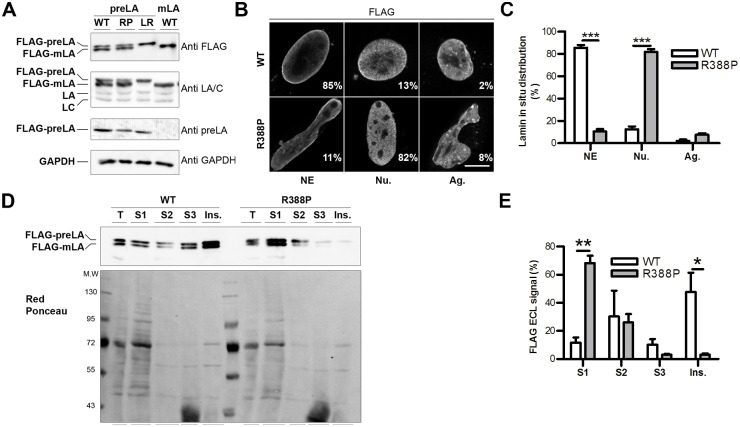
p.R388P mutation alters solubility and nuclear envelope targeting of lamin A.A) Whole cell extracts of C2C12 cells overexpressing wild-type (WT), R388P (RP), L647R (LR) FLAG-LA or WT FLAG-mature LA (mLA) were analysed by western blot using anti-FLAG, anti-LA/C (which recognise ectopic and endogenous A-type lamins), anti-prelamin A (preLA) and anti-GAPDH antibodies. B) C2C12 cells overexpressing WT or R388P FLAG-LA were fixed, labelled with anti-FLAG antibodies, and immunofluorescence observed at the confocal microscope. Representative cells presenting either a strong FLAG-lamin A staining at the nuclear envelope (NE), a predominant nucleoplasmic staining (Nu.) or the presence of small aggregates with ring—like structures (Ag.) are shown. Scale bar, 10 μm. C) Percentage of the three phenotypes NE, Nu. and Ag. for cells expressing WT or R388P FLAG-LA, as indicated. Data are the mean ± s.e.m. of 5 independent experiments and 100–250 nuclei/condition, *** p < 0.001 (two-way ANOVA with Bonferroni post-tests). D) C2C12 cells overexpressing WT or R388P FLAG-LA underwent cell fractionation to enrich the insoluble nuclear matrix intermediate filament scaffold. Proteins from soluble (S1, S2, S3) and insoluble (Ins.) fractions as well as whole cell extracts (T) were analysed in parallel by western blot using anti-FLAG antibodies. Samples loaded in each lane correspond to an identical cell number. Red Ponceau staining of nitrocellulose membrane illustrates the protein specificity of each fraction. E) ECL signals obtained in D) were scanned and quantified. The graph illustrates the distribution of FLAG tagged proteins into the different fractions assuming that 100% of the signal correspond to the total of signals recovered in [S1 + S2 + S3 + Ins.]. Data are the mean ± s.e.m. of 3 independent experiments. ** p < 0.01 and * p < 0.05 (two-way ANOVA with Bonferroni post-tests).